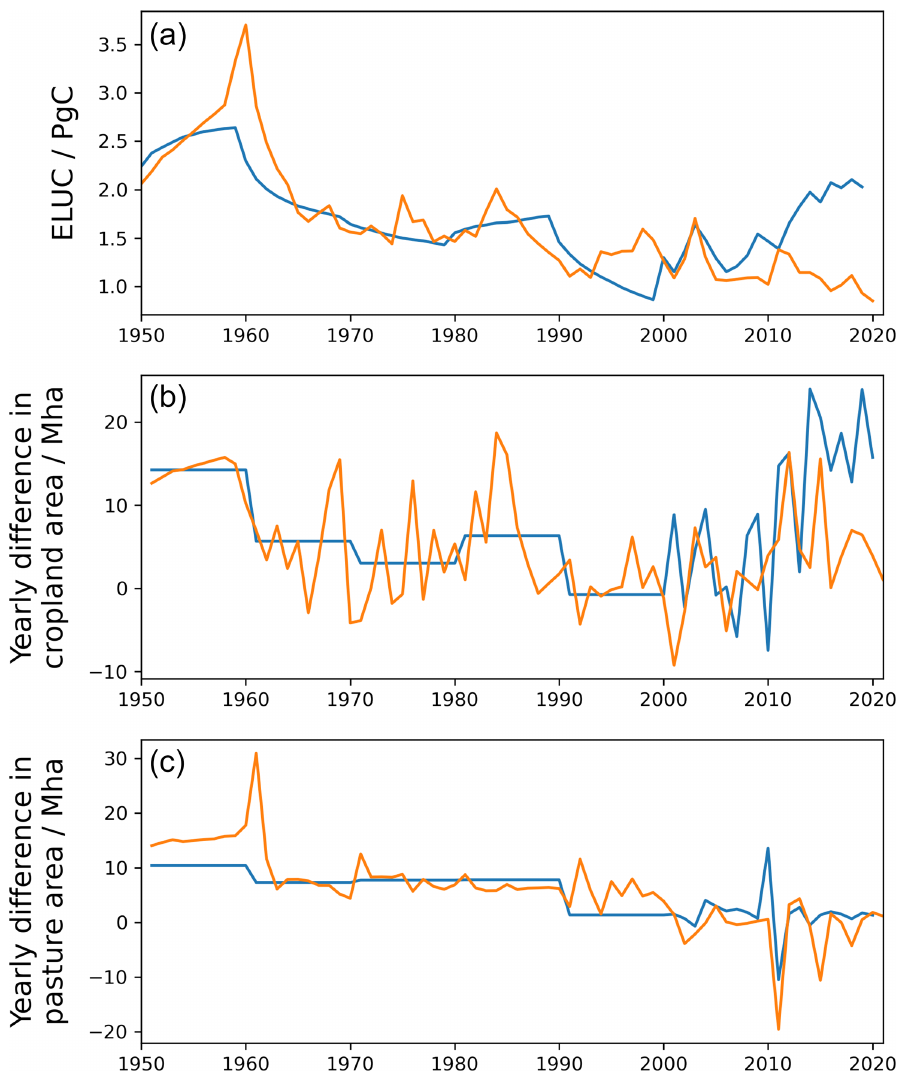
Figure B6. Changes in the HYDE/LUH2 land-use forcing from last year’s global carbon budget (Friedlingstein et al., 2020, in blue) to this year (orange). Shown are year-to-year changes in cropland area (b) and pasture area (c) . To illustrate the relevance of the update in the land-use forcing to the recent trends in E LUC , (a) shows the land-use emission estimate from the bookkeeping model BLUE (original model output, i.e. excluding peat fire and drainage